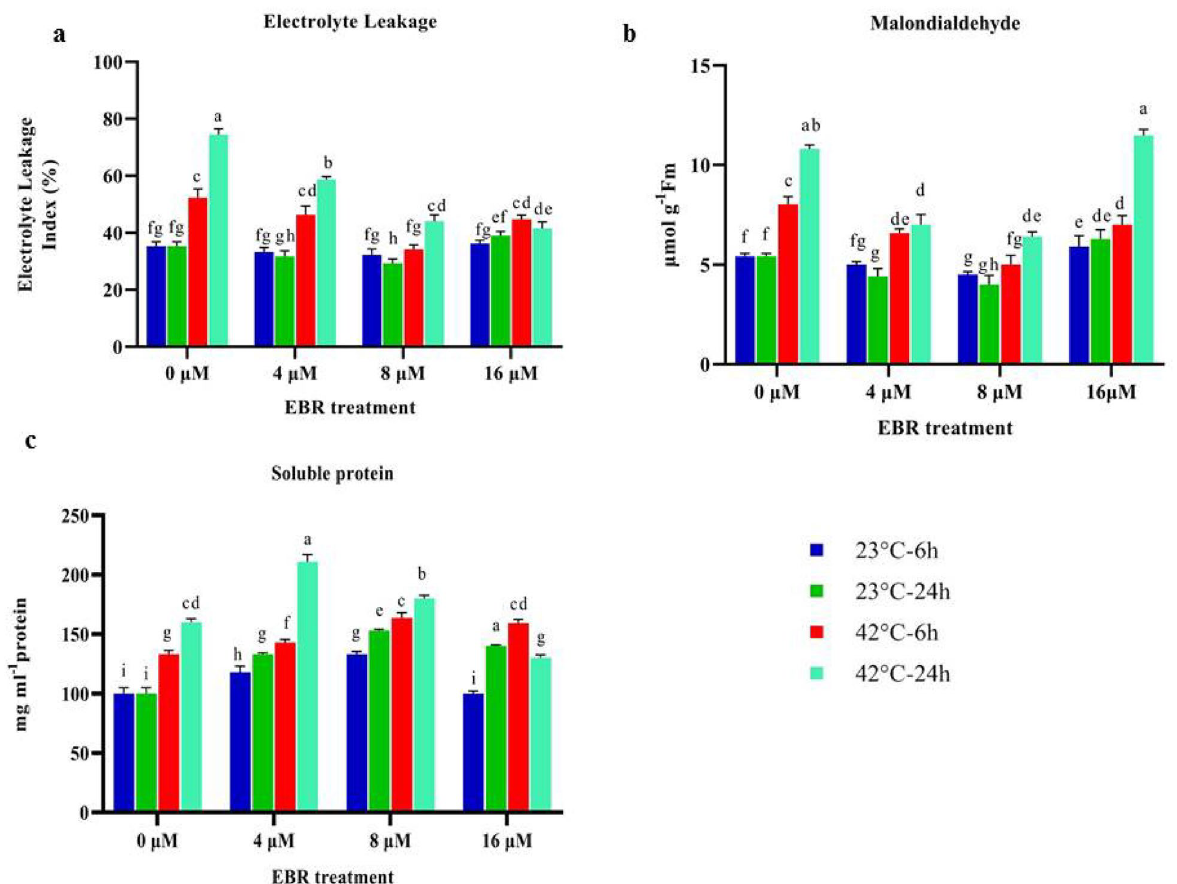
Figure 2. The effects of temperature, harvesting times, and different levels of EBR on electrolyte leakage ( a ), MDA ( b ), and total soluble protein ( c ). Duncan method at a 1% probability level was applied to compare mean values. The columns having similar letters had no significant